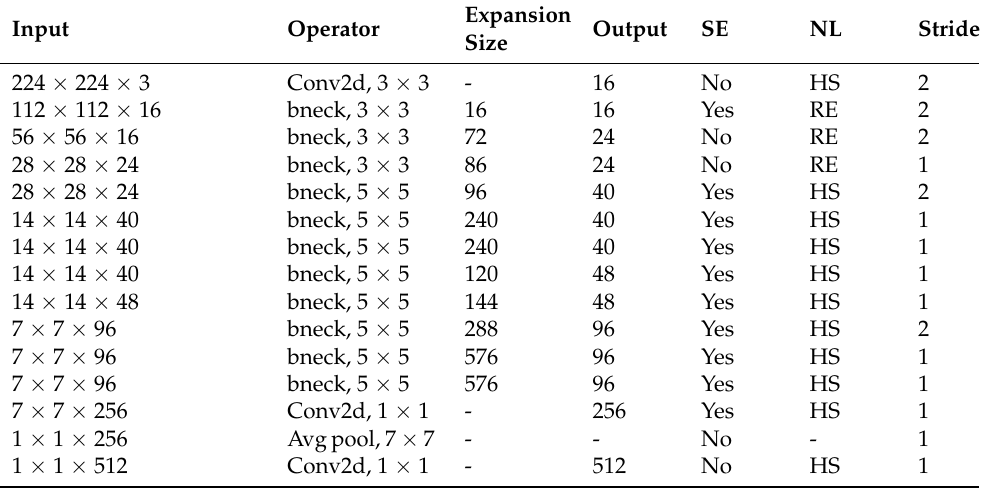
Figure 7. Framework of the pretrained Inception-V3 utilized for the features extraction of CLAHE CXR images. Table 3. Parameter for the modified MobileNet-V3. bneck represents bottleneck convolution, SE depicts whether there is a Squeeze-and-Excite in that block, NL represents the type of non-linearity utilized, HS represents h-swish, RE denotes ReLU and S represents